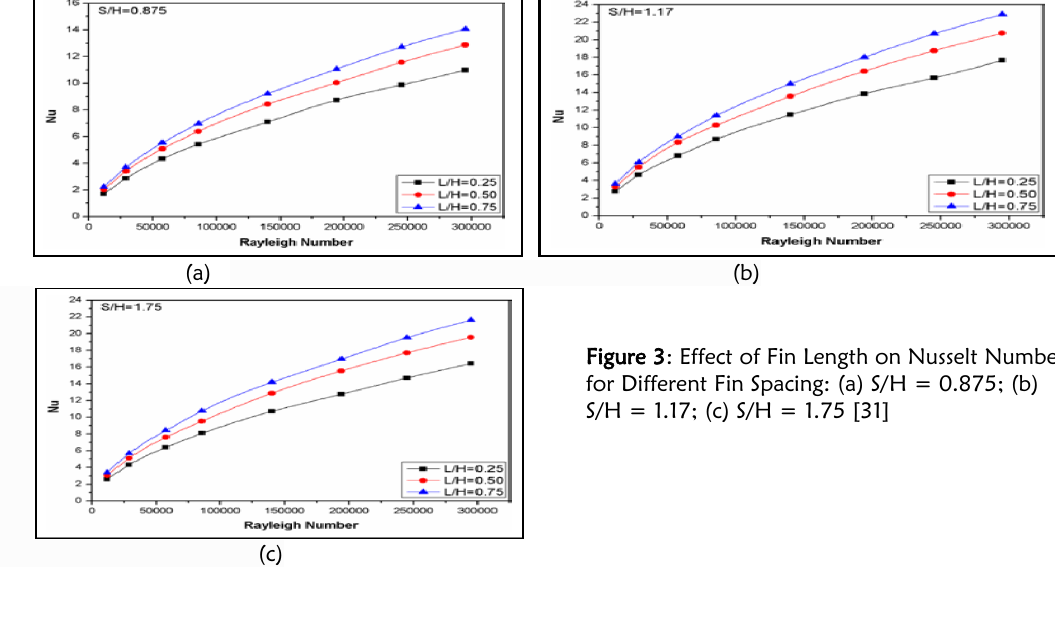
Figure 3: Effect of Fin Length on Nusselt Number for Different Fin Spacing: (a) S/H = 0.875; (b) S/H = 1.17; (c) S/H = 1.75